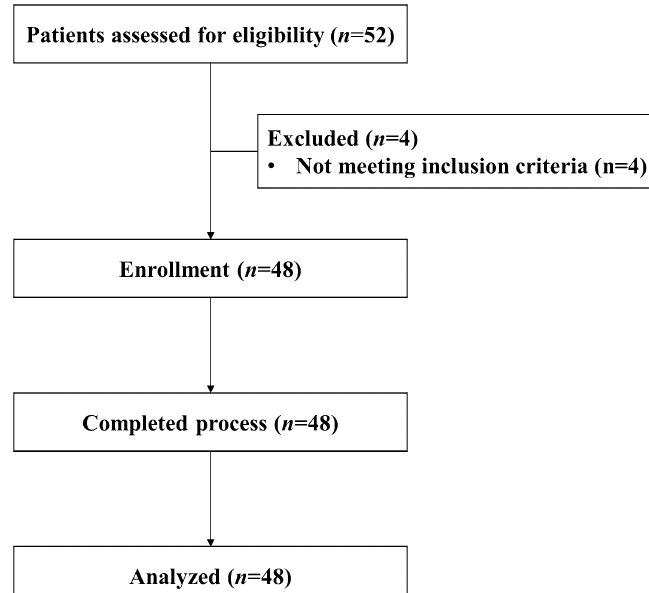
Figure 2. CONSORT diagram.